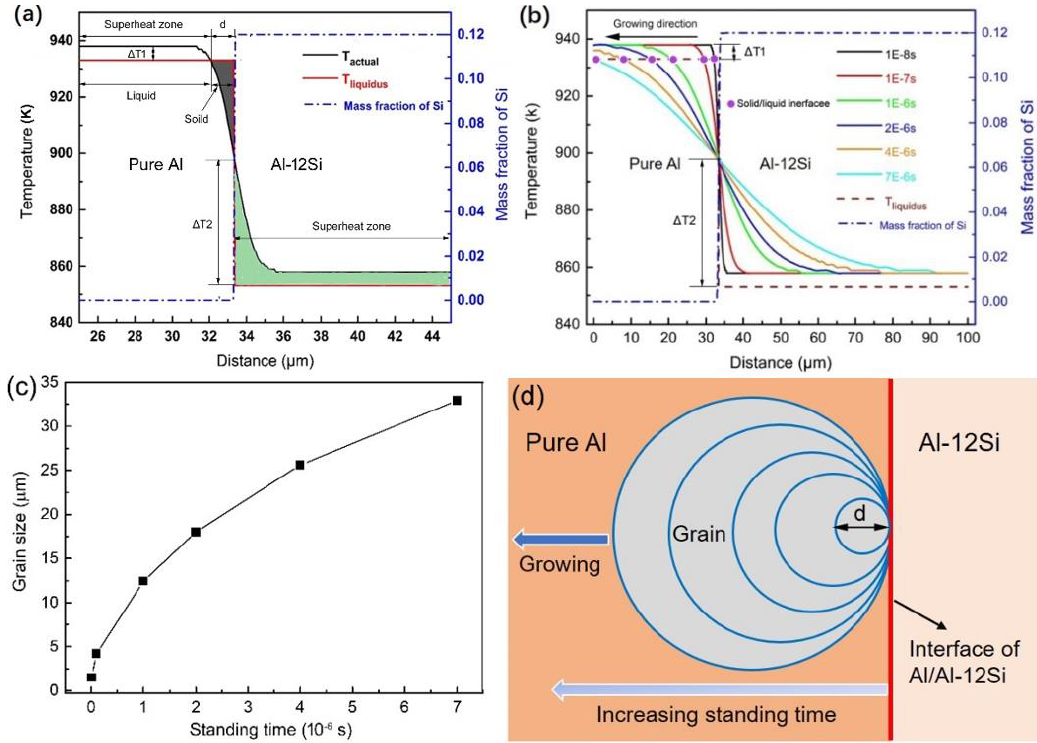
Figure 11. Interface conditions between pure Al and Si-12Si melts when standing for ( a ) 10 −8 s and ( b ) different lengths of time ranging from 10 −8 s to 7 × 10 −6 s; ( c ) variation in grain size due to standing time; and ( d ) schematic of grain growth.